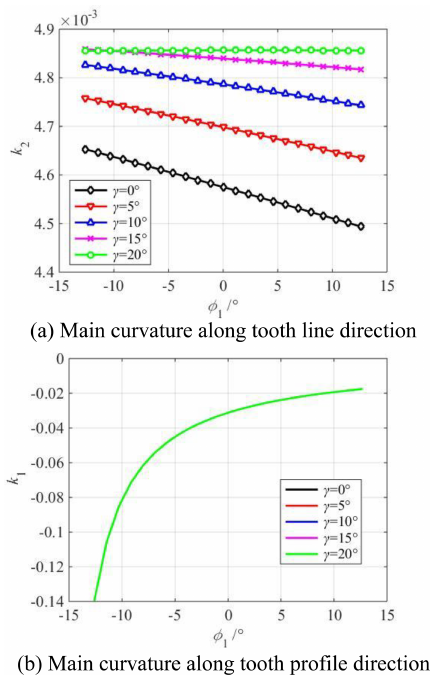
Figure 7. Influence of cutter inclination angle γ on main curvature of modified concave tooth